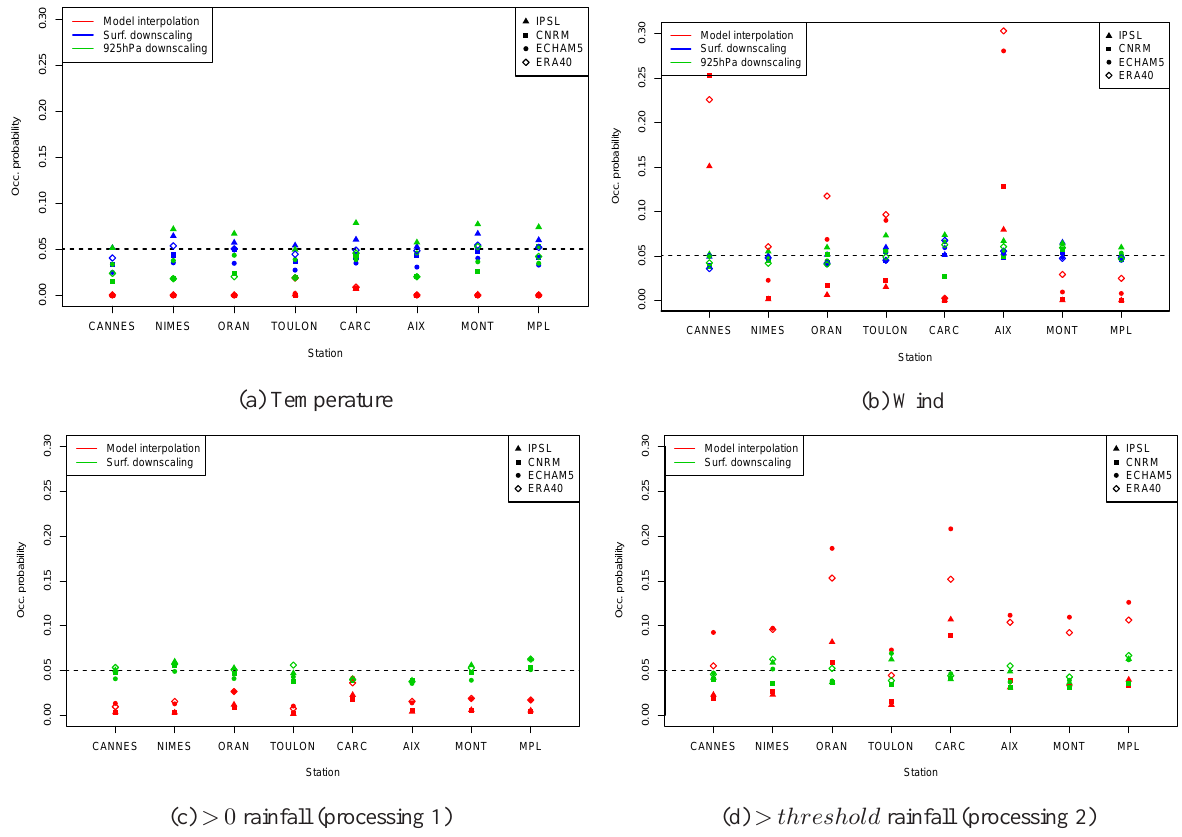
Fig. 4: Probability of having interpolated and downscaled data, at 925 hPa and surface levels (in red, blue and green respec- tively) from models and reanalyses larger than the 95% quantile of the observations for the validation period. The signs indicate the model used, triangle for IPSL, square for CNRM, circle for ECHAM5 and empty diamond for ERA40. The dashed lines correspond to the 5% occurrence probability.